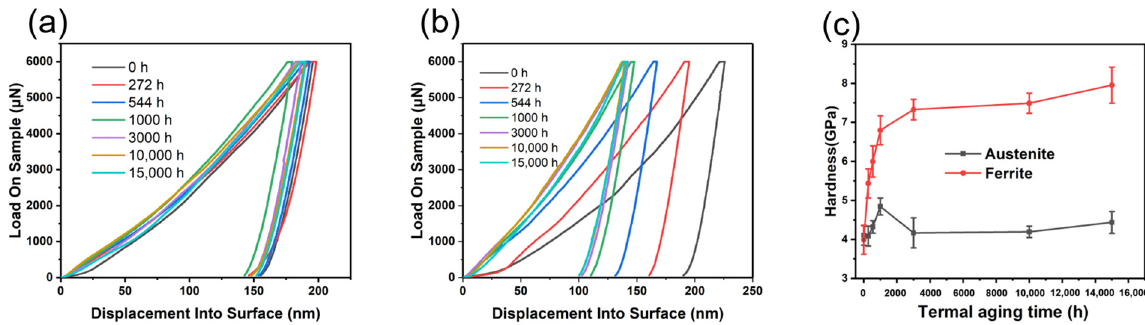
Figure 10. Load–displacement curves for the austenite ( a ) and ferrite ( b ) of Z3CN20-09M stainless steel after different amounts of aging. The computed microhardness is also given ( c ).